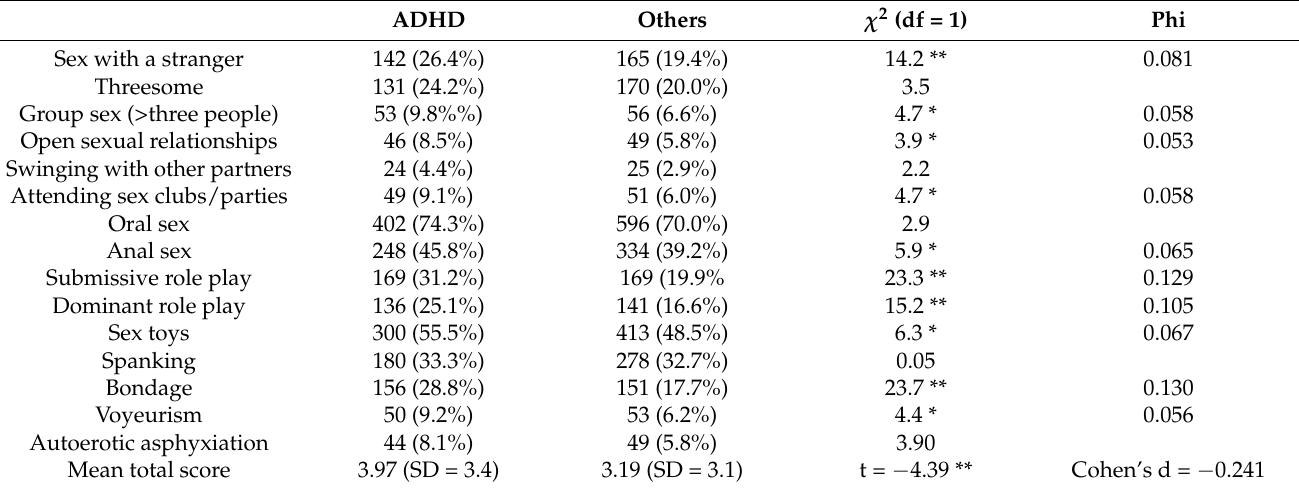
Table 10. Differences in sexual practices between ADHD and Other participants ( n = 1392).